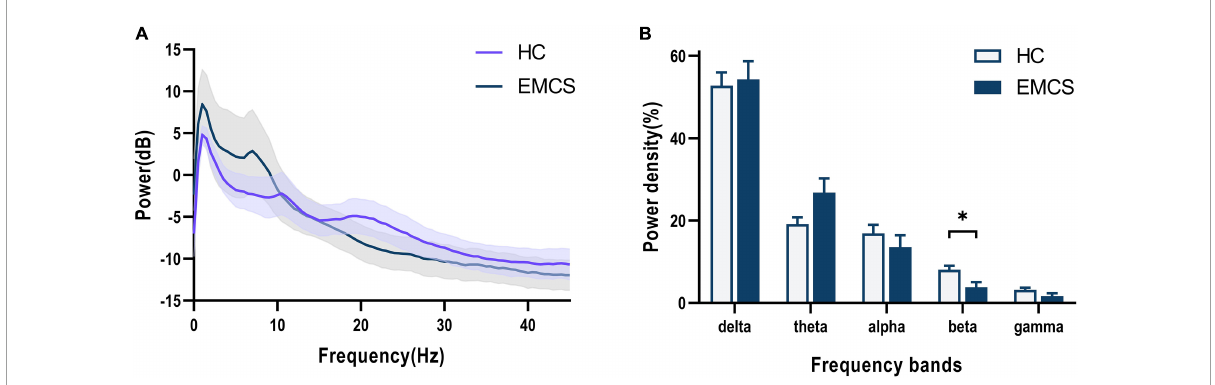
FIGURE1 Frontoparietal changes in the EEG power spectra in the emergence from minimally conscious state (EMCS) group compared with the healthy control (HC) group. (A) The average absolute EEG power in HCs (purple line) and EMCS patients (blue line). The Y-axis represented the log-transformed power. (B) The relative power in five frequency bands. A marked decrease in the relative power in beta frequencies was observed in the EMCS group compared with the power in the HC group ( ∗ P < 0.01, after Bonferroni correction for frequency bands). The data were expressed as the means ± SEM.